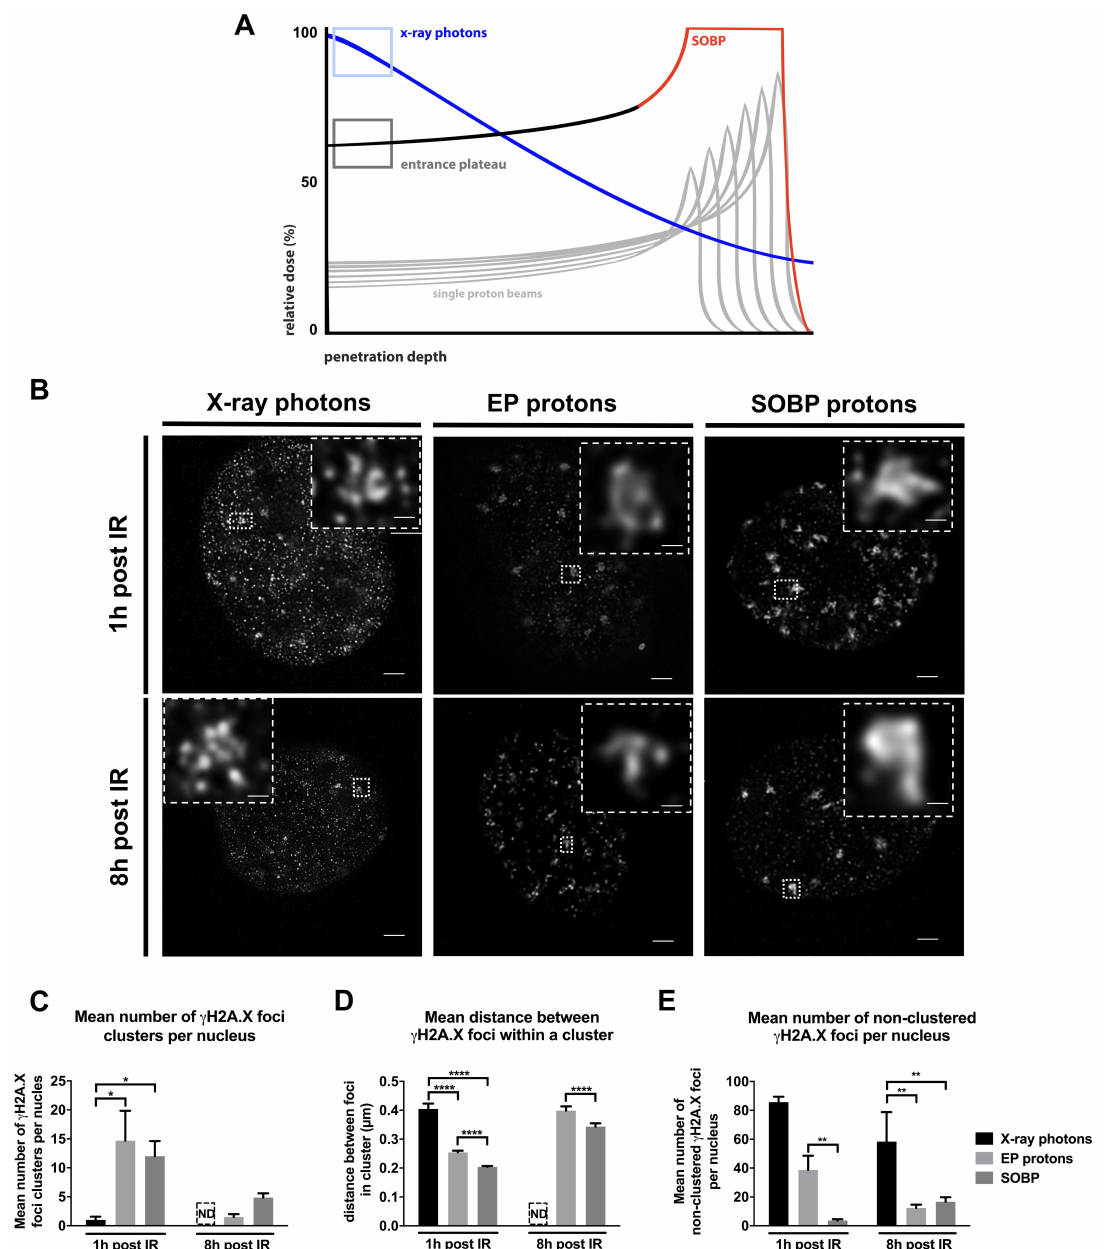
Figure 1. Time-dependent induction and removal of γ H2A.X foci in MEFs irradiated with a physical dose of 3 Gy of X-ray photons, EP and SOBP protons visualized by γ H2A.X staining. ( A ) Model of irradiation setup. Depth-dose curves of an X-ray photon beam and a proton beam highlighting the depth area where the cells were irradiated with X-ray photons, Bragg-peak protons and plateau protons. ( B ) STED microscopy pictures of a single nucleus of MEFs after 1 h and 8 h of 3 Gy irradiation with X-ray photons, EP protons or SOBP protons (objective 100 × ); scale bar: 0.1 µ m. Clustered γ H2A.X foci were additionally zoomed in 40 × (small squares in the edge). Scale bar: 0.1 µ m. ( C – E ) Quantification of γ H2A.X foci in MEFs irradiated with 3 Gy of X-ray photons, EP and SOBP protons. ( C ) Average number of clusters per nucleus. ( D ) Average distance between γ H2A.X foci in clusters. ( E ) Average number of foci per nucleus beyond clusters. Data represent mean ± SEM; One-way ANOVA with Tukey’s multiple comparisons post-test and Kruskal–Wallis test; * p < 0.05; ** p < 0.01; **** p < 0.0001; ND – not